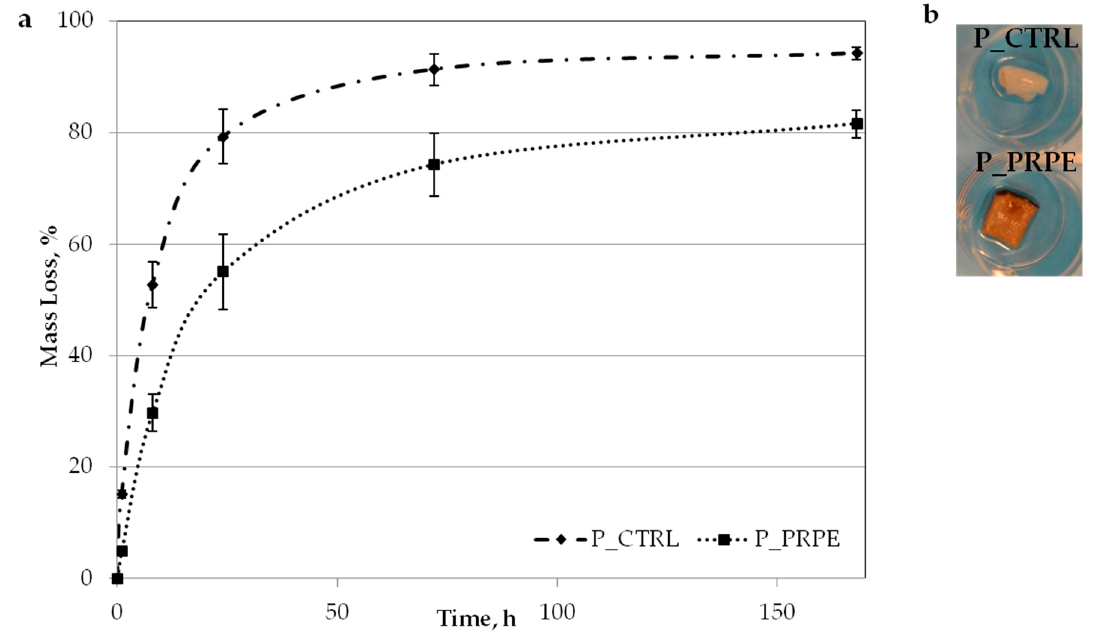
Figure 8. ( a ) Degradation rate of P_CTRL and P_PRPE in collagenase 1 mg/mL over a one week time range. ( b ) Pictures of P_CTRL and P_PRPE after soaking for one week in a solution of 1 mg/mL of collagenase